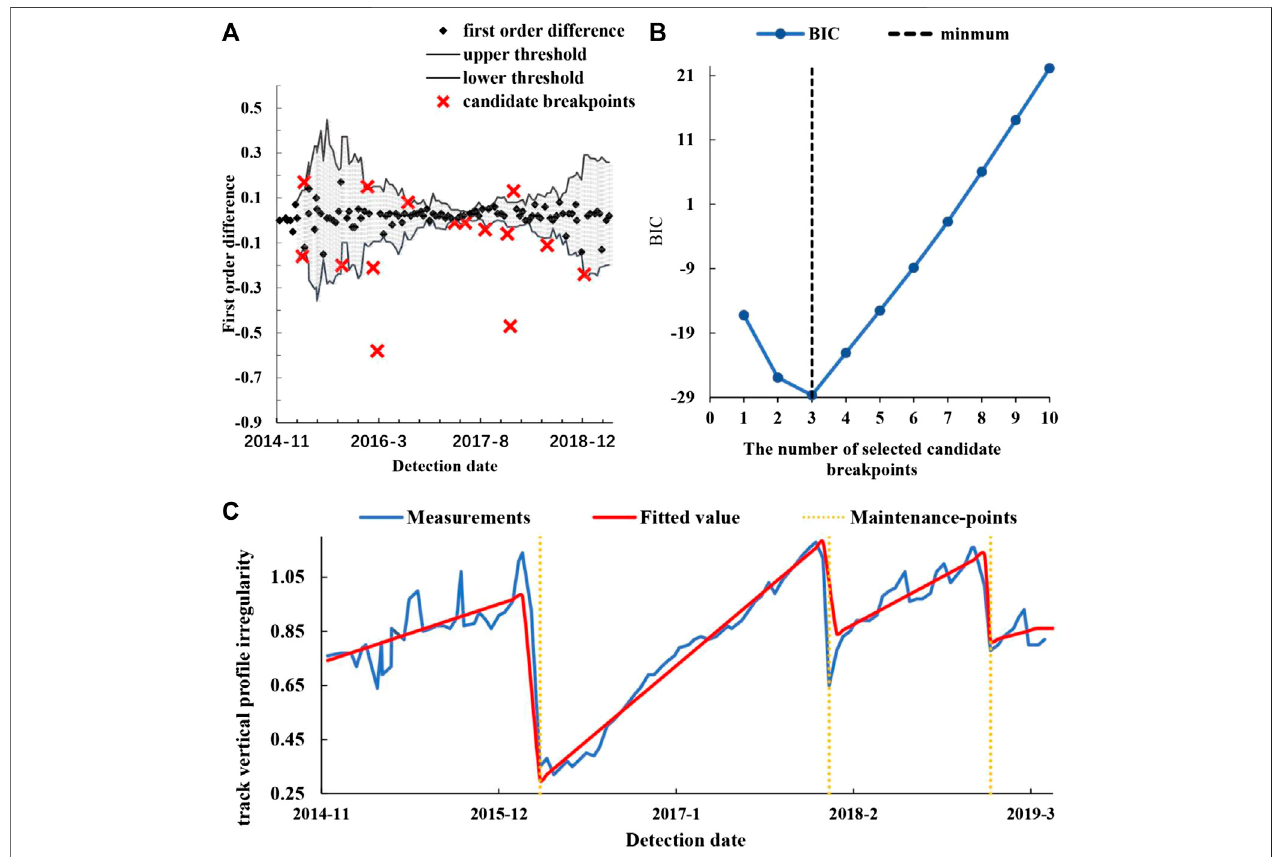
FIGURE 6 | The identi fi ed maintenance-points and piecewise fi tting model of section two: (A) the candidate breakpoints identi fi ed by adaptive thresholding method; (B) the value of BIC for a different number of selected candidate breakpoints; (C) the piecewise fi tting model.